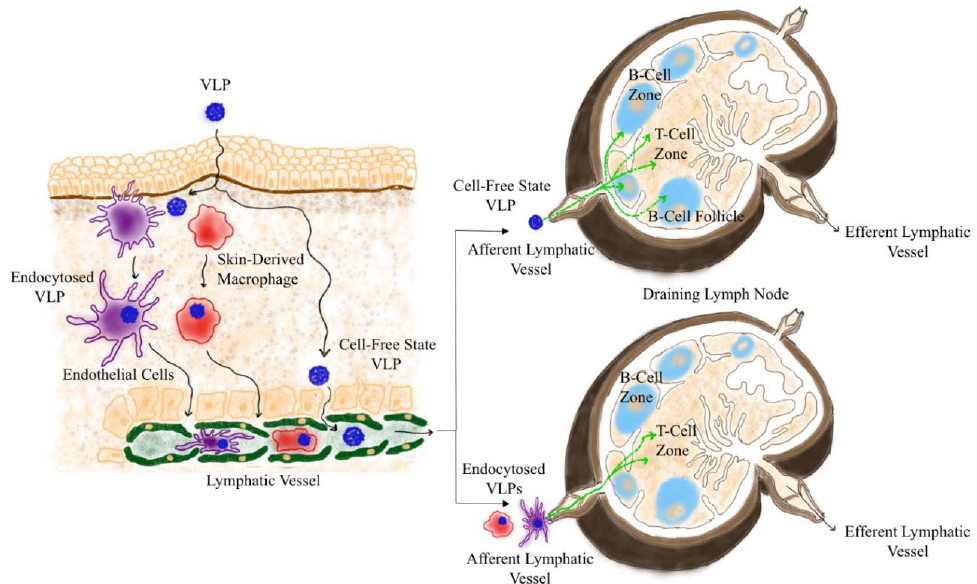
Figure 2. Distribution of VLPs in the draining LN. VLPs arrive in the LNs by natural drainage in a cell-free manner or transported by APCs. Upon reaching the sub-capsular sinus of the draining LN, VLPs will be phagocytized by different APCs and preferentially reach the B and/or T-cell zones. VLPs endocytosed in the periphery by APCs preferentially reach the T-cell zone in the draining LN for T-cell priming.